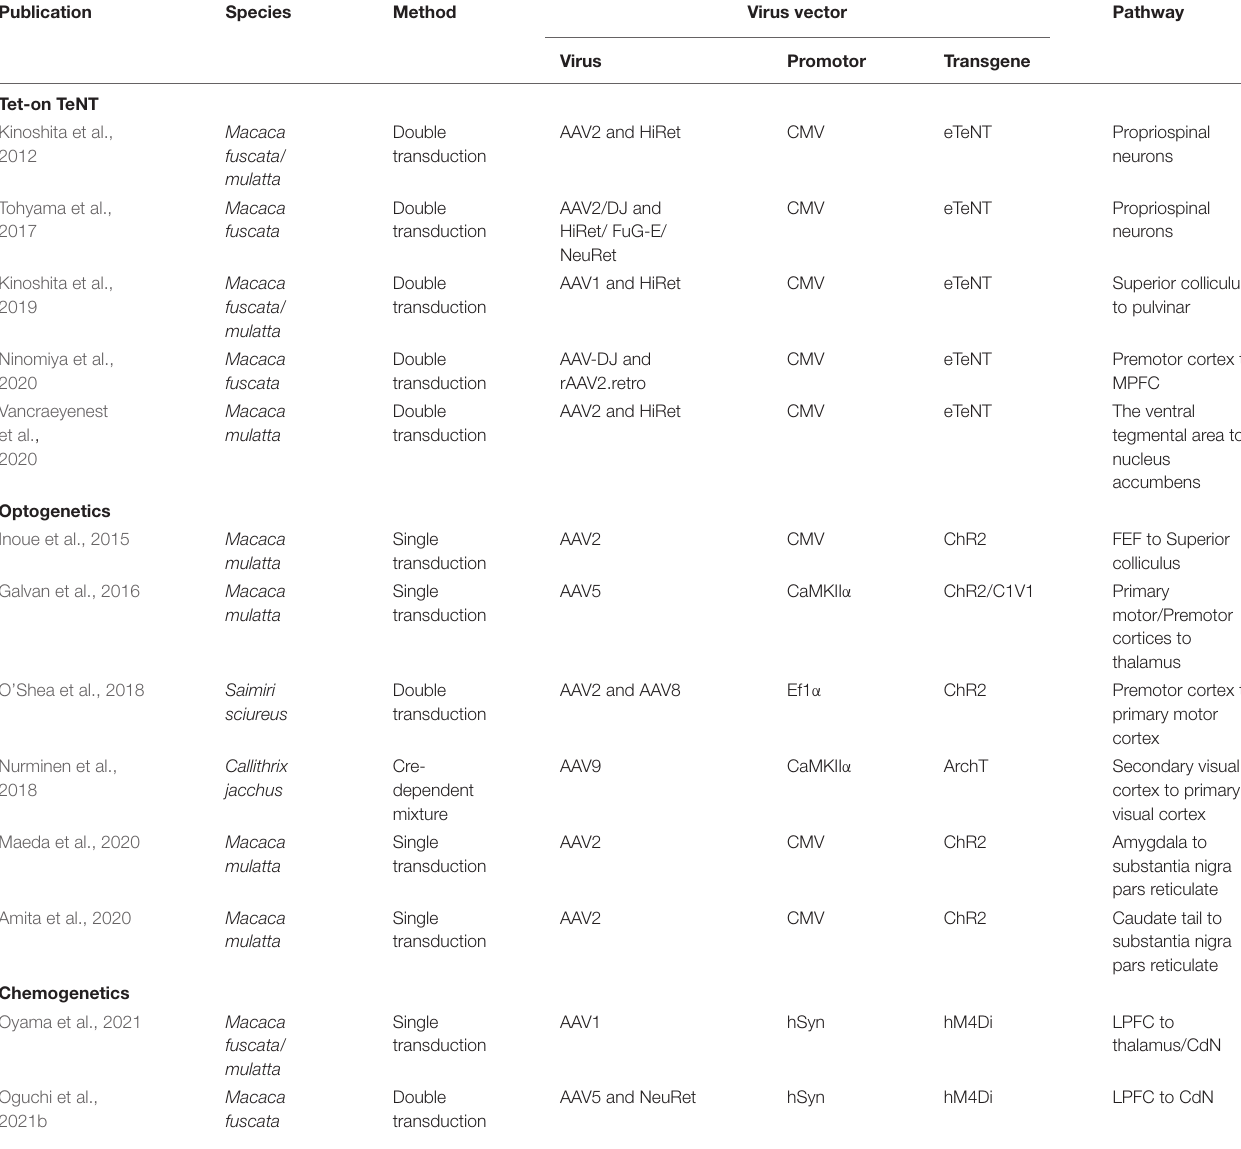
TABLE 1 | Summary of publications using pathway-selective manipulation methods in non-human